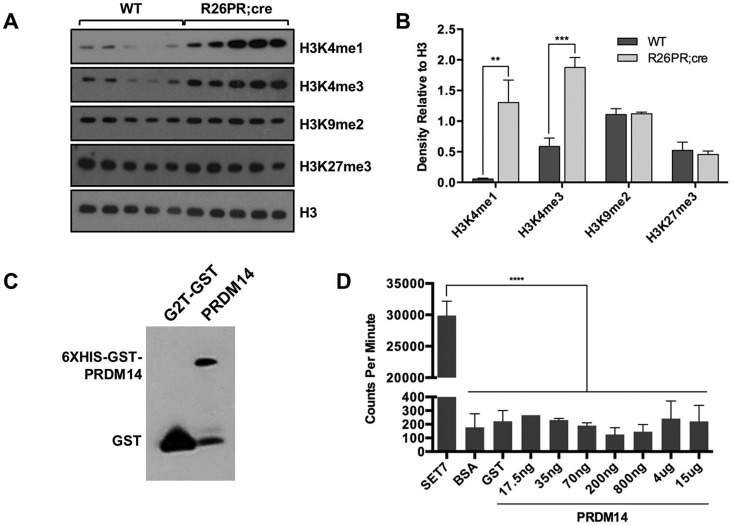
Global epigenetic changes in PRDM14-induced T-ALLs. (A) Western blot for global histone modifications using histone extracts prepared from wild-type (WT) thymi (n=5) and R26PR;cre thymic tumors (n=5). (B) Densitometric quantification of A, with whole H3 used for normalization. (C) Western blot for GST on purified recombinant G2T-GST (control; 26 kDa) and GST-PRDM14 (90 kDa) protein. (D) H3 HMTase activity assay for positive control (SET7), negative control (BSA, GST), and PRDM14 recombinant proteins. Mean±s.d. shown for all graphs. **P≤0.01, ***P≤0.001, ***P≤0.0001.